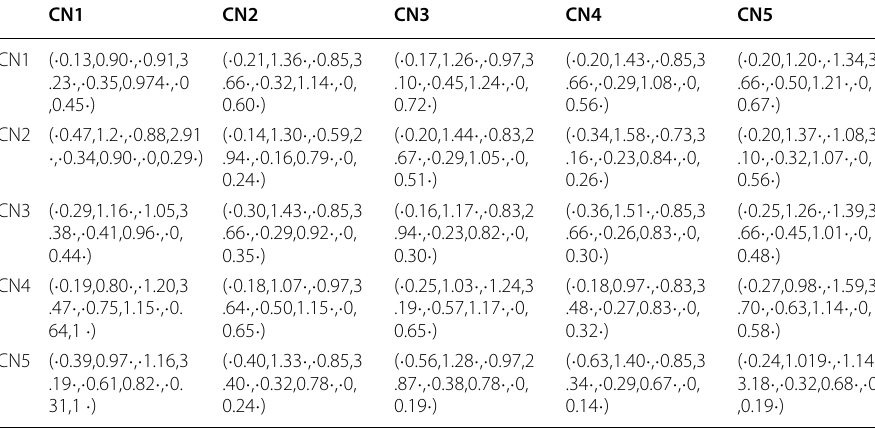
Table 18 Picture fuzzy rough sets for the